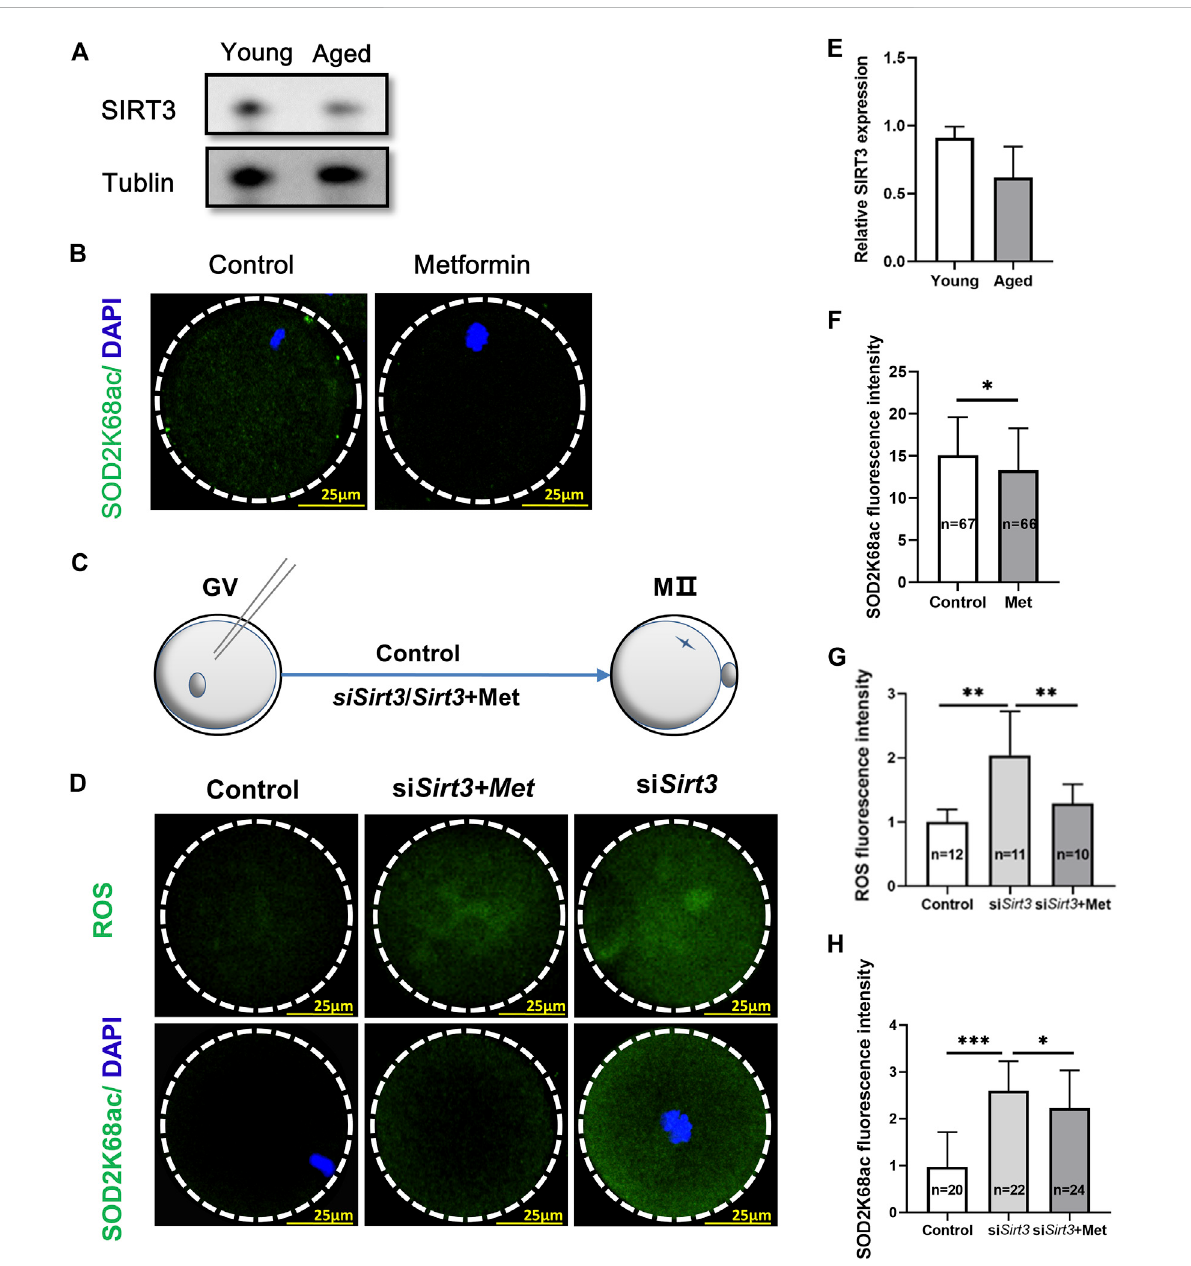
FIGURE 6 Oocytes from aged mice have reduced SIRT3 levels and metformin treatment can mitigate SIRT3-induced SOD2K68ac in oocytes from aged mice. (A) Immunoblotting showing reduced SIRT3 expression in GV stage oocytes after IVM from aged mice (42 – 45 weeks) compare with young (6 – 8 weeks) mice. Tublin was used as a loading control. (B) Representative immuno fl uorescence images of SOD2K68ac in M Ⅱ stage oocytes after IVM with or without metformin treatment. Scale bar, 25 μ m. (C) Schematic illustration of the experiment to assess whether metformin treatmentofoocytesfromagedmicethatwereinjectedwithaSirt3-targetingsiRNAaffectsSOD2K68aclevels. (D) Metforminlowerstheacetylation levels of SOD2K68 and ROS upon the reduction of SIRT3 expression by comparing the injected control (PBS), siSirt3 (injected with Sirt3 siRNA), and siSirt3 + metformin treatment oocytes from aged mice. Scale bar, 25 μ m. (E) Quanti fi cation of the data from panel A; the samples comprised 100 oocytes from the young and old mice. (F) Quanti fi cation of the data from panel B; the samples comprised 100 oocytes from the young and old mice. (G,H) Quantitative analysis of the data from panel D. Data are means ± SD of at least three independent experiments. Means ± SD, * p < 0.05, ** p < 0.01, *** p < 0.001 vs. control as calculated by two-tailed unpaired Student ’ s